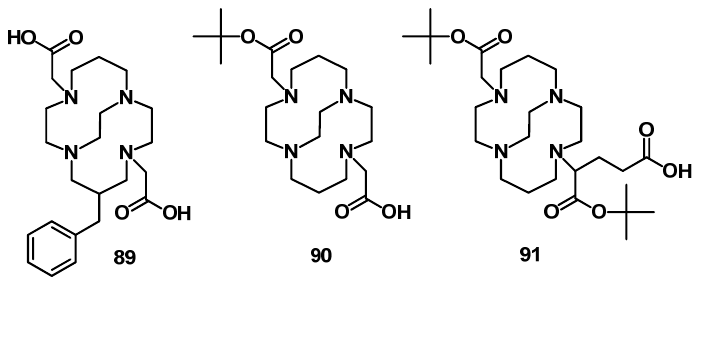
Figure 9. Chemical structures of the CB-TE2A